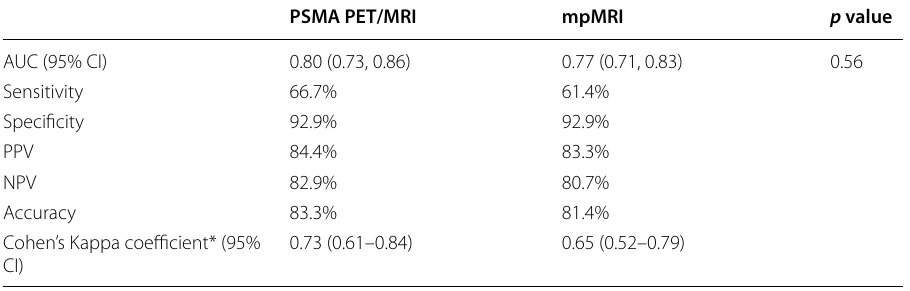
Table 2 Per-quadrant accuracy and interreader agreement results for PSMA PET/MRI and mpMRI for detection of csPCa